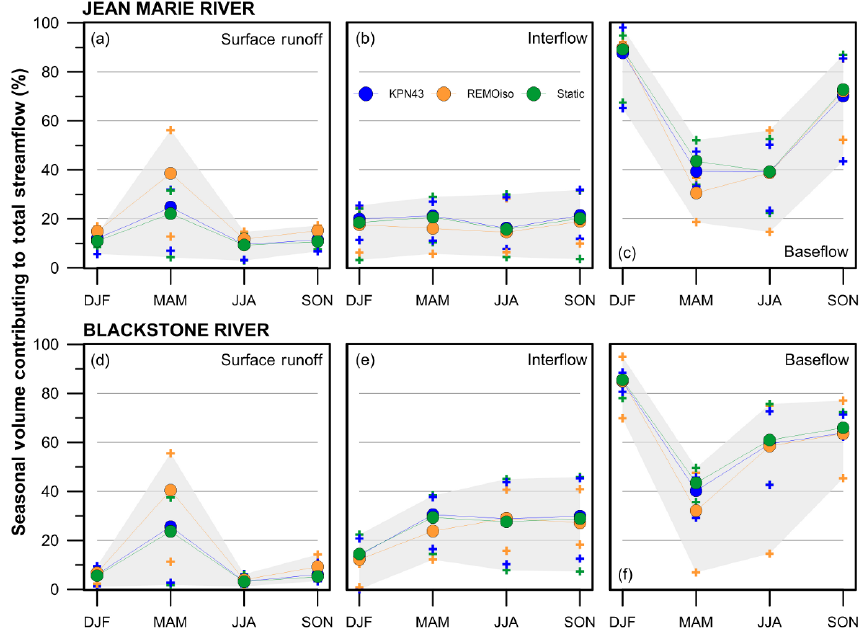
Figure 6. Percent seasonal volume contributing to total streamflow from surface runoff, interflow, and baseflow storages for each season. Cross symbols represent the 5th and 95th percentiles for each forcing method, and circle symbols signify the mean values. The combined uncertainty bounds representing the 5th and 95th simulations from all three δ 18 O ppt input types are shaded in